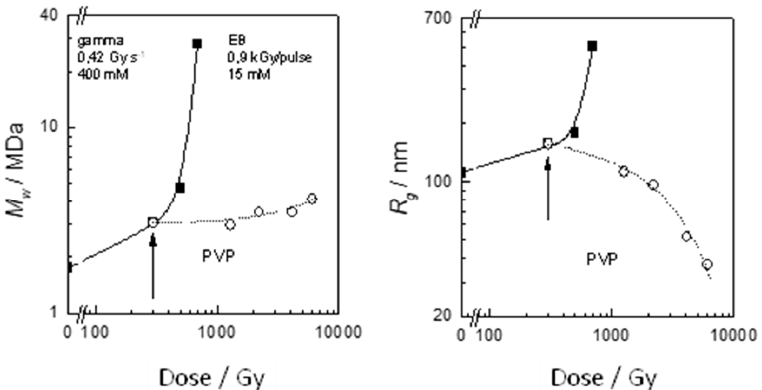
Figure 26. Two-step synthesis of PVP nanogels. M w and R g as a function of total absorbed dose. Black symbols denote continuous low-dose-rate gamma irradiation at a polymer concentration of 400 mM. In the two-step procedure, at the point marked by an arrow, irradiation conditions are changed—the second step (open symbols) is pulsed EB irradiation at the PVP concentration of 15 mM. Based on [305].